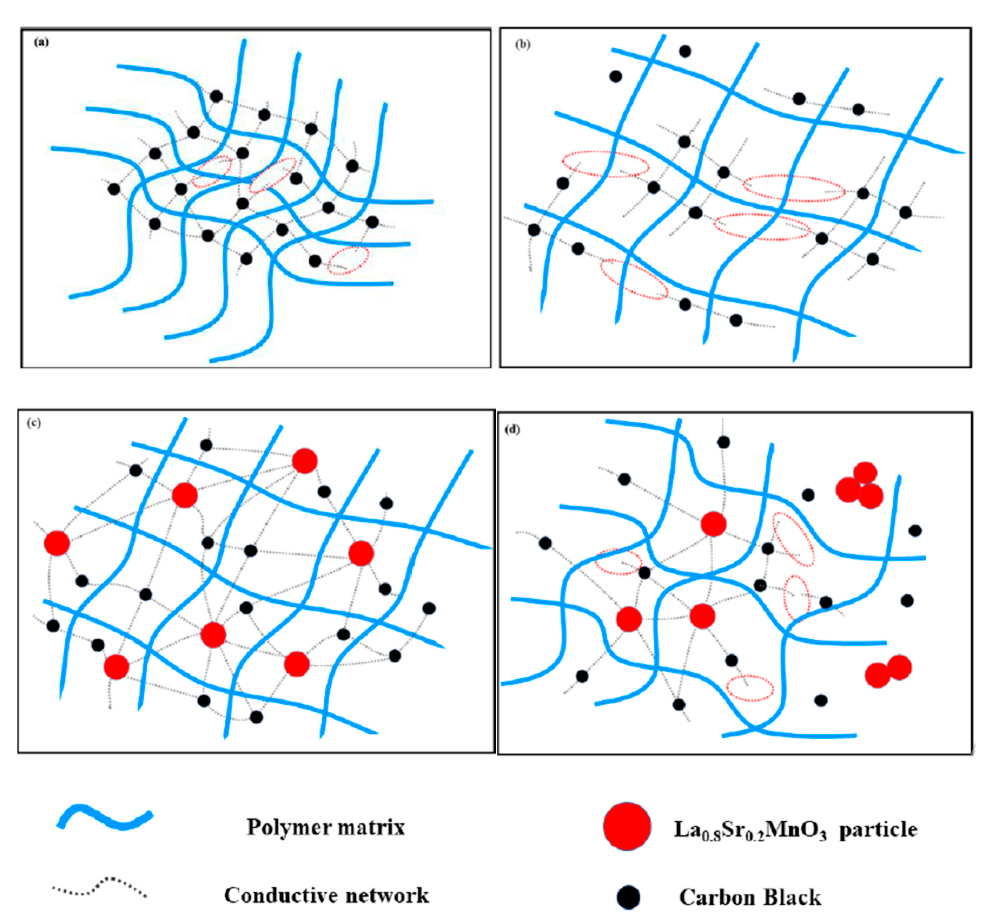
Figure 11. The schematic diagram of the forming of conductive network in different semi-conductive composites at different temperatures. ( a ) Semi-conductive composites without La 0.8 Sr 0.2 MnO 3 at room temperature; ( b ) semi-conductive composites without La 0.8 Sr 0.2 MnO 3 Near the melting point; ( c ) semi-conductive composites with 6 wt.% La 0.8 Sr 0.2 MnO 3 near the melting point; ( d ) semi-conductive composites with 10 wt.% La 0.8 Sr 0.2 MnO 3 near the melting point.